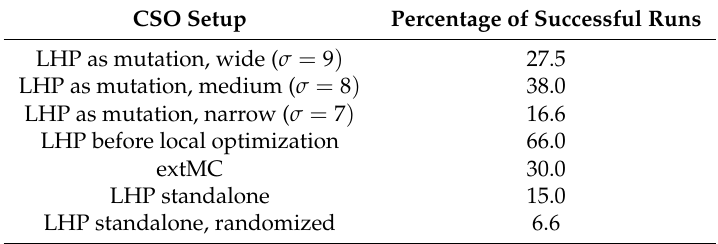
Table 2. Percentage of runs finding the true global minimum within 2 million steps for different cluster structure optimization (CSO) setups, as discussed in the